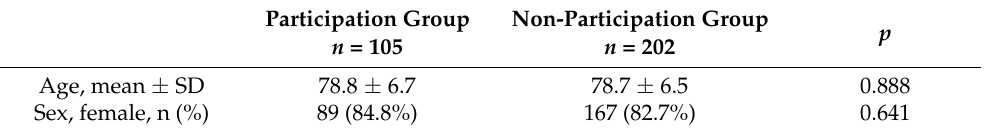
Table 1. Demographic characteristics between the participation and non-participation